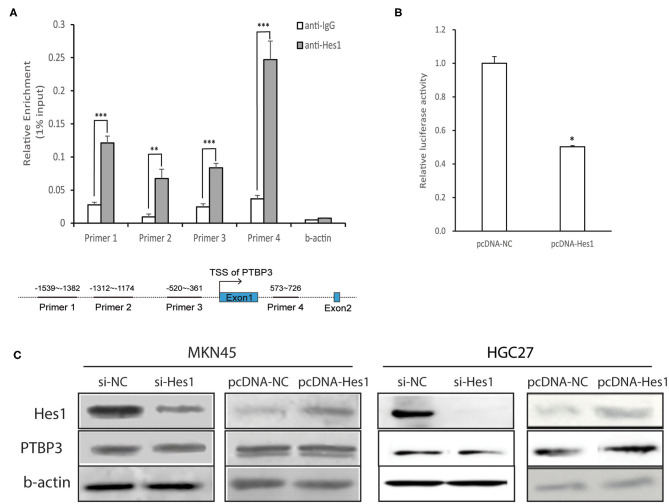
Hes1 represses the activity of the PTBP3 promoter but did not affect PTBP3 protein expression. (A) MKN45 cells were cultured and lysates were subjected to ChIP assay. Four paired primers were designed near the predicted binding sites of Hes1. The ChIP assays verified the association of Hes1 and the promoter of PTBP3 gene. The results are expressed as the mean ± S.D. of three independent experiments. **P < 0.01, ***P < 0.001 vs. anti-IgG. (B) The 5′-upstream promoter region (1,098 bp) was inserted into the pGL3-basic plasmid. Reporter activity was also analyzed after transfection of pcDNA (Hes1) into gastric cancer cells. All error bars are mean ± S.D., n = 3. *P < 0.05. (C) Cells in Si-NC group were transfected with non-targeting siRNA as a negative control. In Si-Hes1 group, cells were treated with Hes1 siRNA. The pcDNA-NC group refers to cells transfected with a blank vector. The pcDNA-Hes1 group refers to cells transfected with Hes1-overexpressing plasmids. After 48 h following transfection, total proteins were extracted, and Hes1 and PTBP3 protein expression were measured. Hes1 expression has no influence on PTBP3 expression in MKN45 and HGC27 cells.